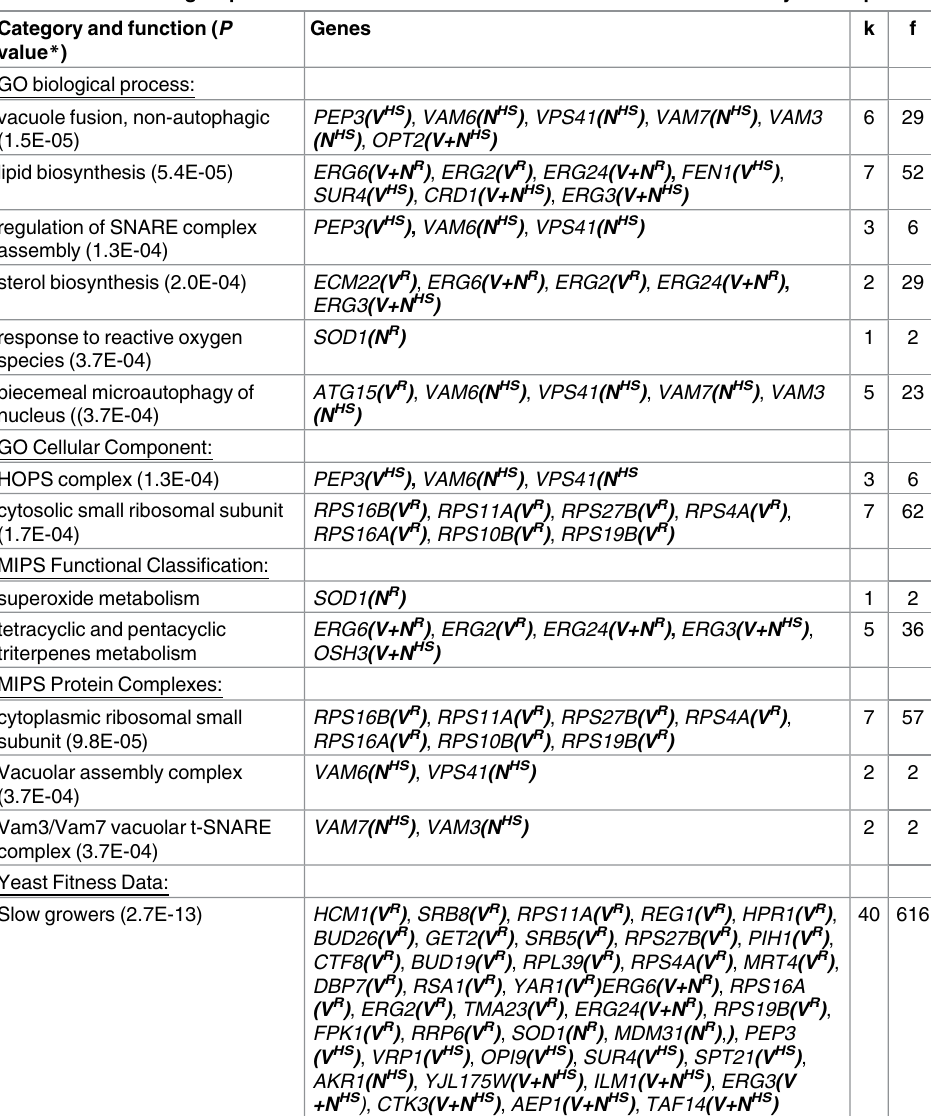
Table 2. Functional groups enriched in the screen for mutants with altered sensitivity to ionophores. Category and function ( P Genes k f value * ) GO biologicalprocess: vacuole fusion, non-autophagic (1.5E-05)